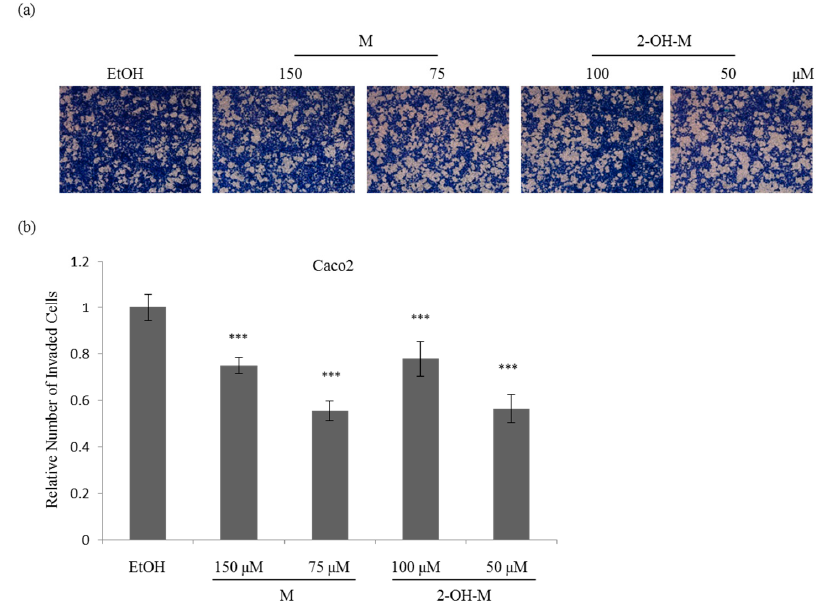
Figure 4. Inhibition of the invasive ability of Caco2 cells by treatment with sub-lethal concentrations of melatonin or 2-hydroxymelatonin. ( a – b ) Invasion assay of Caco2 cells treated with melatonin or 2-hydroxymelatonin dissolved in ethanol ( a ), and quantification of the number of invaded cells in each group ( b ). Representative images from three independent experiments are shown. Data represent mean ± standard error of the mean, n = 3. *** p < 0.001 compared with the ethanol-treated group. EtOH, ethanol; M, melatonin; 2-OH-M, 2-hydroxymelatonin.